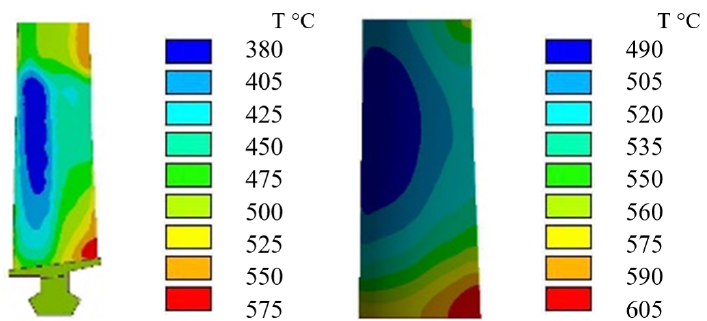
Figure 6. Pressure and temperature field on blade surfaces.